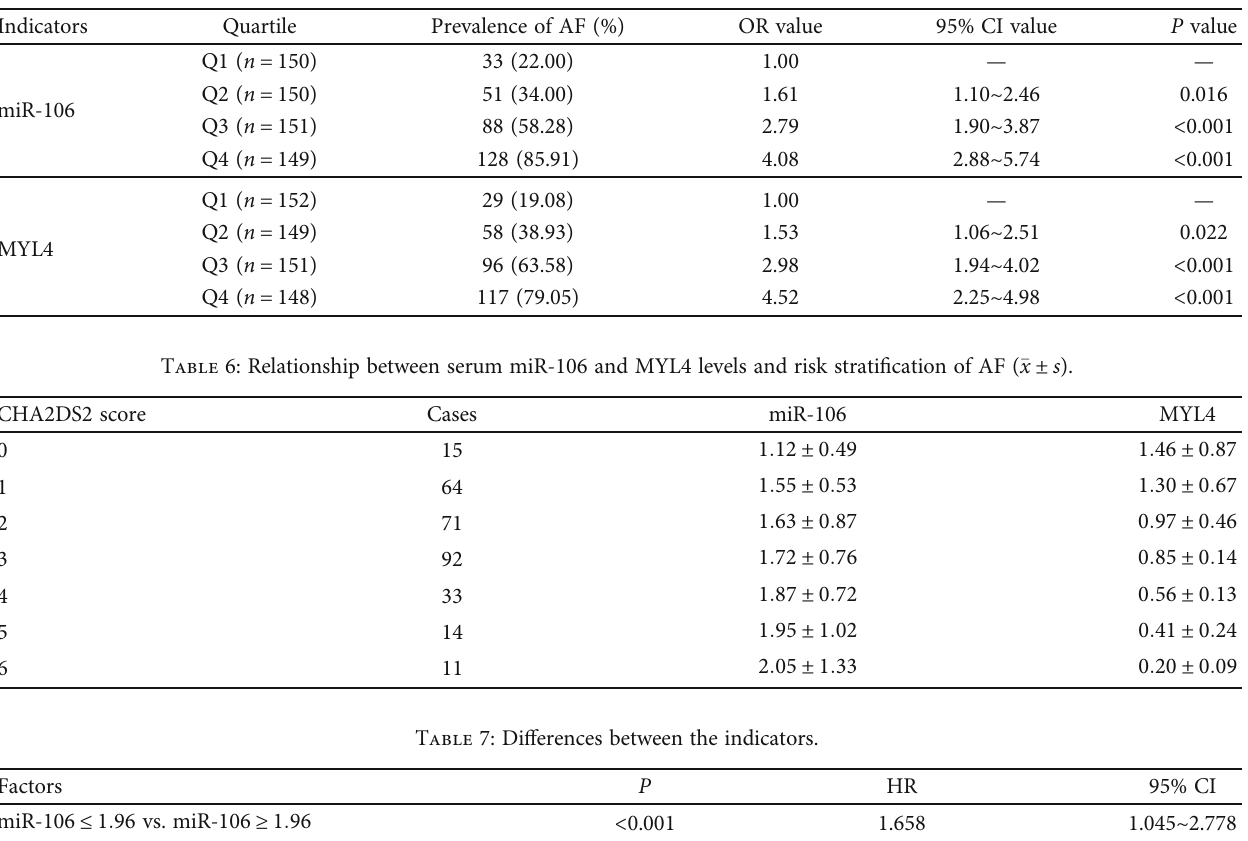
Table 5: Risk of AF prevalence with di ff erent serum miR-106 and MYL4 levels [ n (%)].